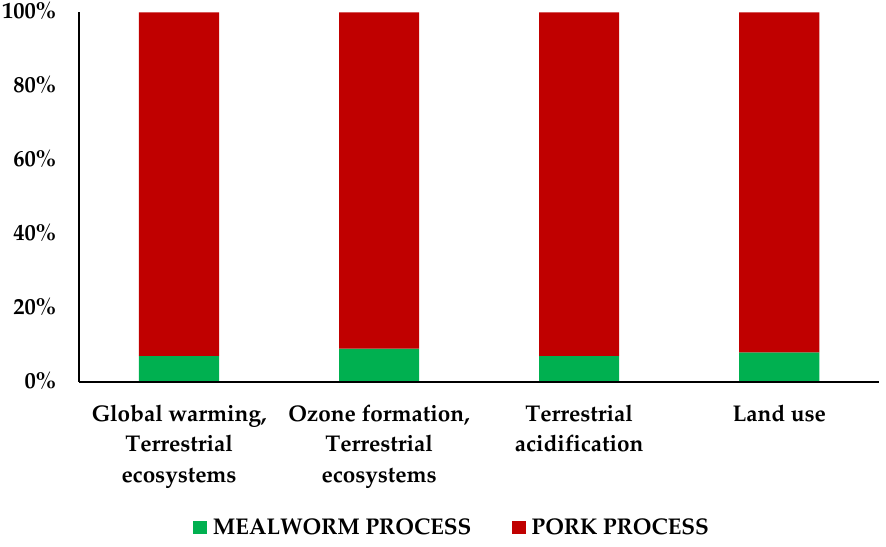
Figure 5. Main impact categories for the ecosystem: comparison within the two production systems. In this study, mealworms are a viable protein alternative, requiring only 9% of the amount of land used to produce one kg of pork